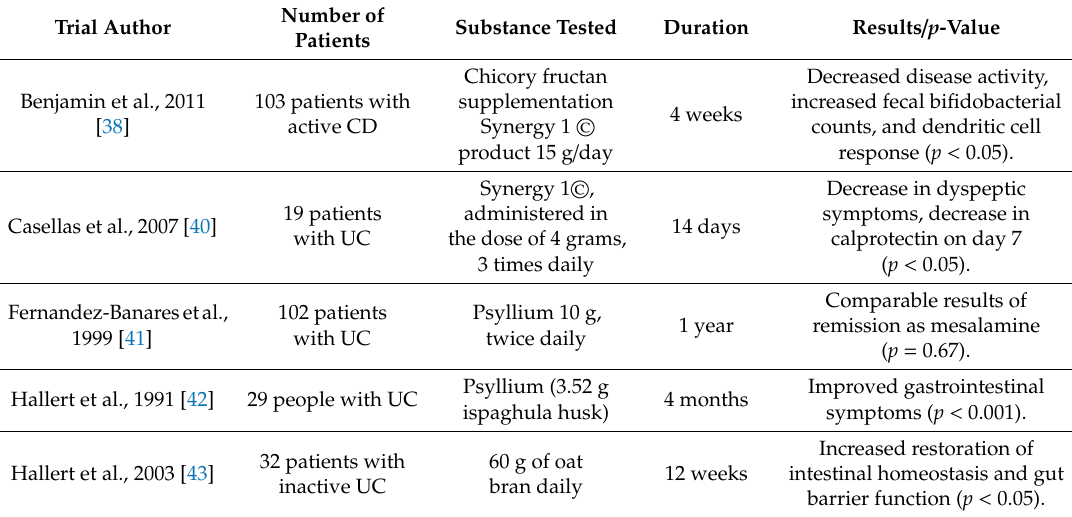
Table 3. Summary of trials examined for e ff ectiveness of Fibers on